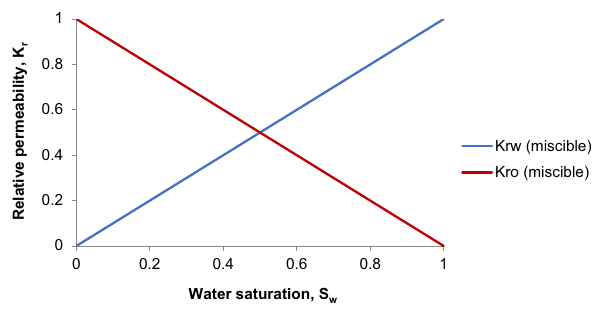
Fig. 8 The model of surfactant flooding in a fractured matrix. The blue part is matrix and the red part is the fracture. There is a horizon- tal injector at the bottom of the fracture and a horizontal producer at the top of the